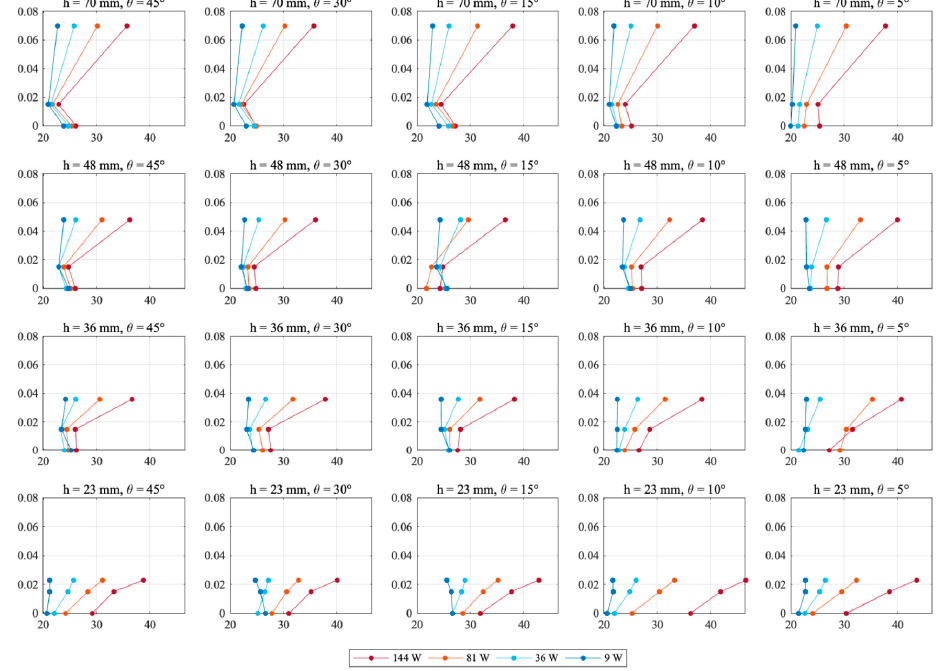
Figure A2. Temperatures (°C) (x-axis), as function of distance from the bottom unheated surface (m) (y-axis). Each plot represents a given air cavity height (h) and roof inclination ( θ ).